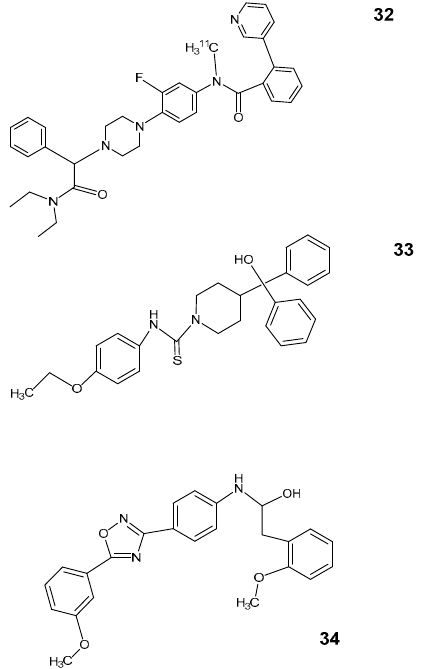
Figure 8. NPY2 ligands: 32 : N - 11 C-Methyl-JNJ-31020028; 33 : SF 11; 34 : SF 31.